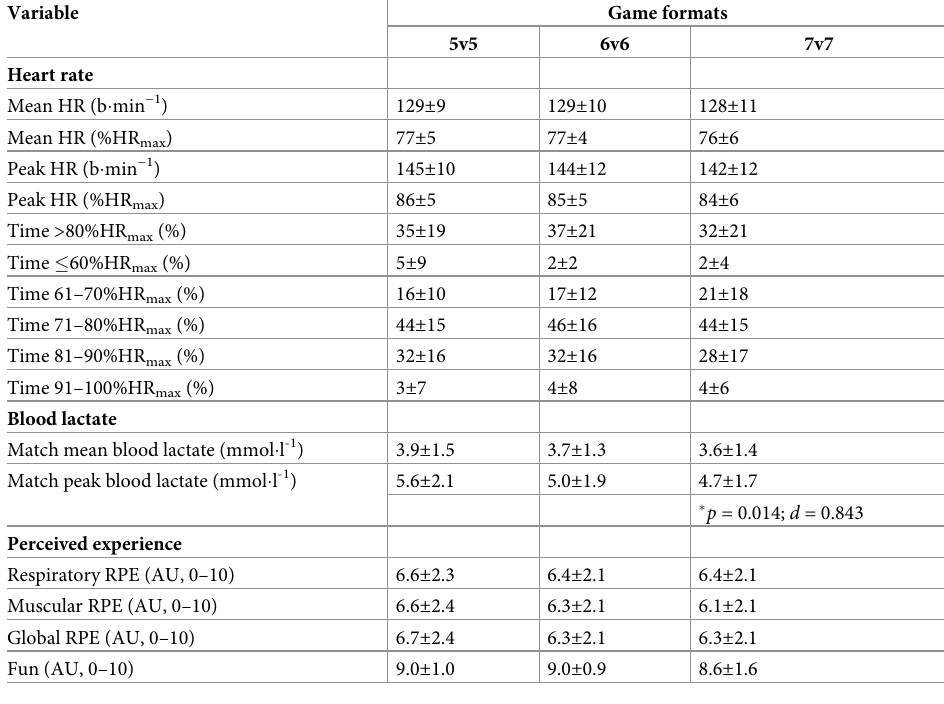
Table 1. Players’ cardiovascular load, perceived experience, and fun levels during 5v5, 6v6 and 7v7 recreational team handball game formats (data are presented as means ± SD).